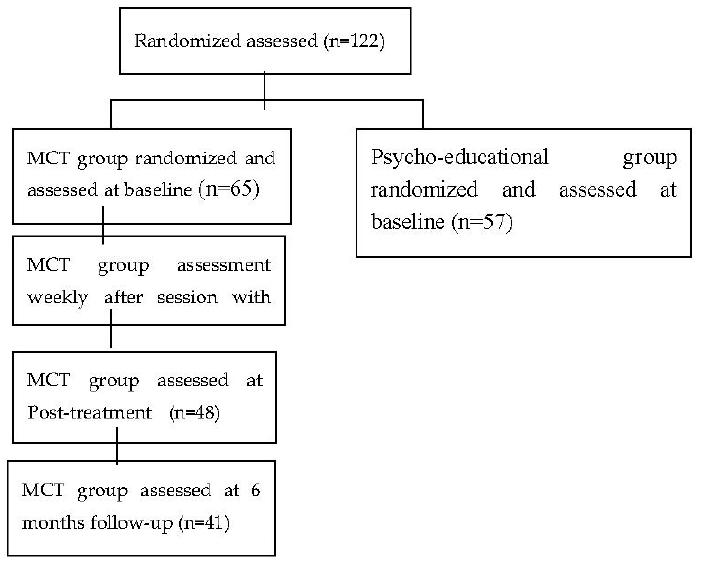
Figure 1. Research process flow-chart. MCT, metacognitive training.